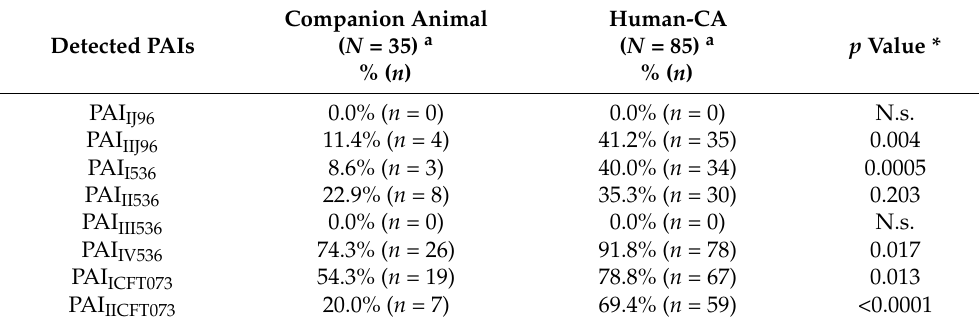
Table 5. Frequency of pathogenicity island markers (PAIs) among 3GC-resistant E. coli strains from companion animals and humans with UTI.